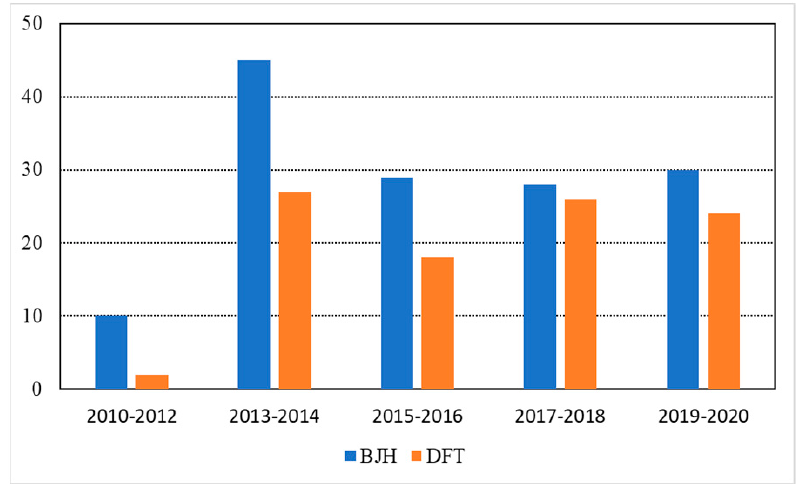
Figure 8. Comparison of the use of BJH and DFT in the last 10 years.